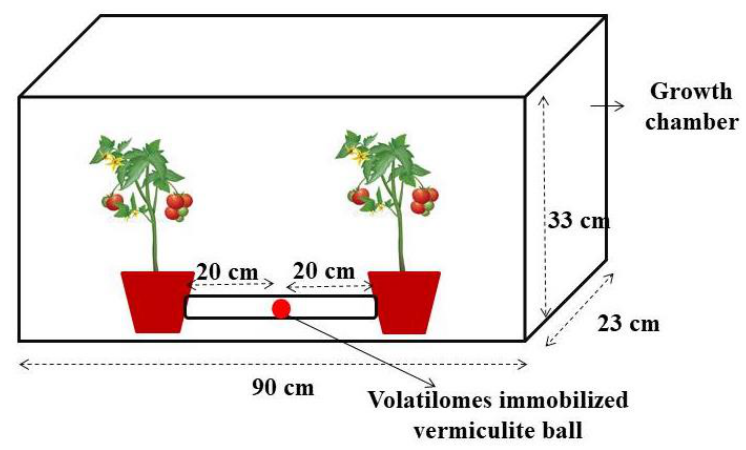
Figure 10. Volatilomes diffusing growth chamber model.